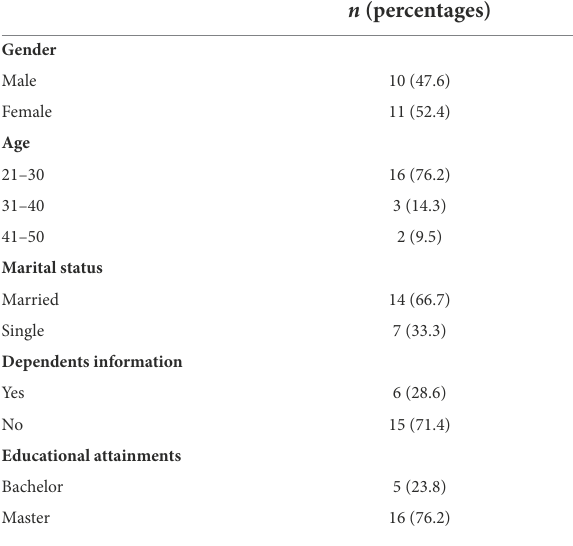
TABLE 1 Demographic characteristics of participants.